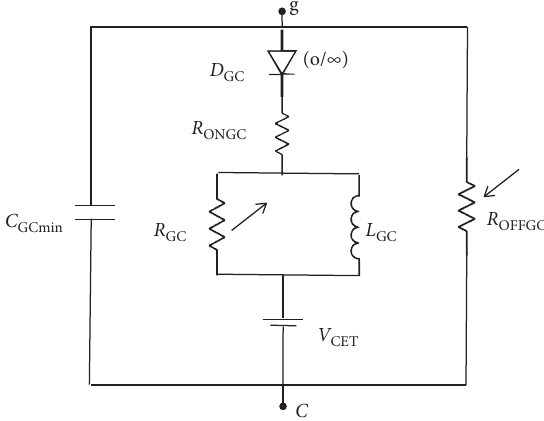
Figure 2: Model of the nonlinear C GC capacity [15].